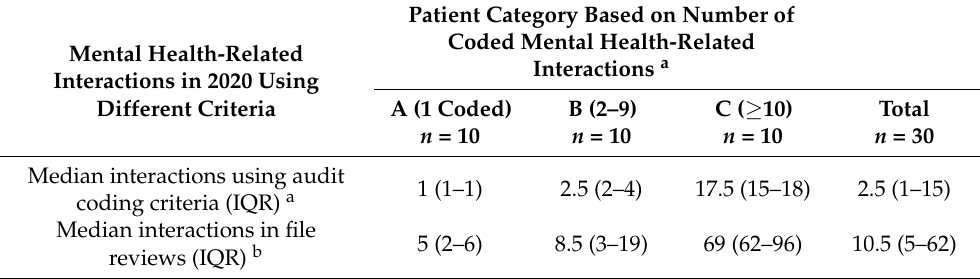
Table 3. Median number of mental health-related interactions in 2020 based on file reviews, with comparison to audit, for 30 patients.